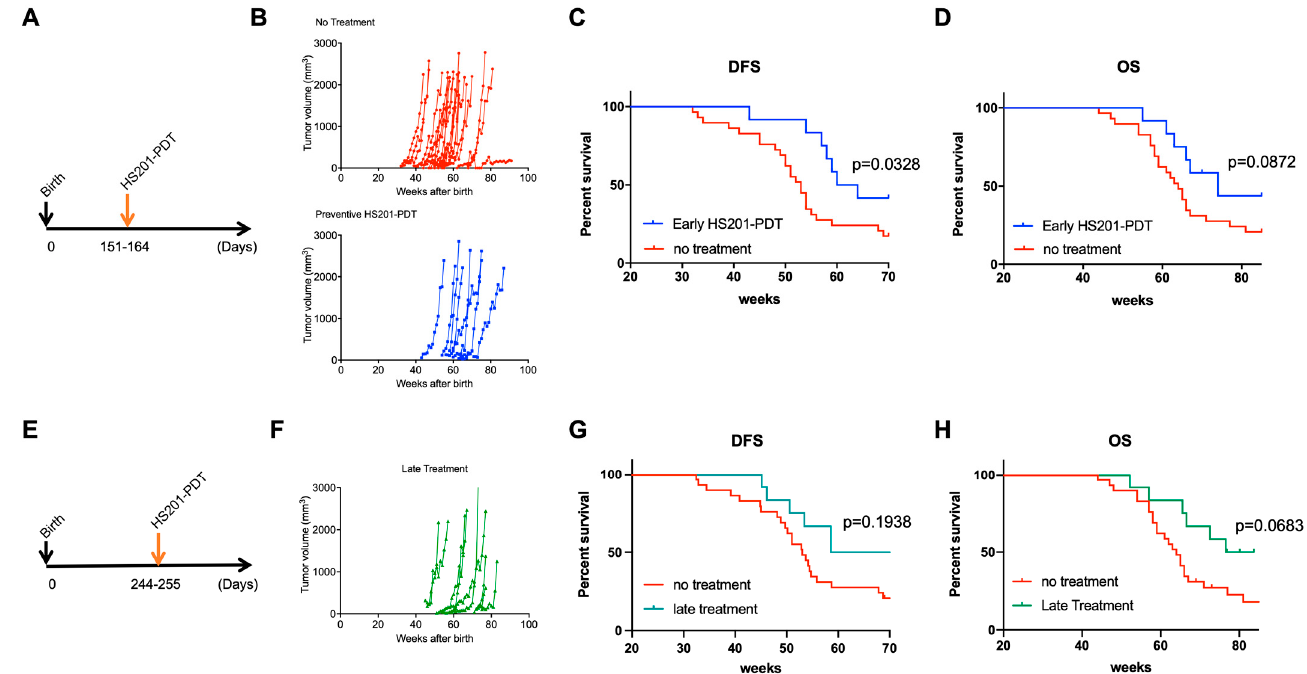
Figure 4. Survival benefits of preventive HS201-PDT for MMTV-neu mice. ( A ) Preventive HS201-PDT was conducted for 5-month-old (151–164 days after birth) female MMTV-neu mice. Six hours after intravenous administration of HS201 (25 nmol/mouse), a 30 J/cm 2 laser dose was used to irradiate each of 7 irradiation areas. Tumor growth was monitored every week until humane endpoints or till the age of 85 weeks. Control mice in no-treatment group were monitored for tumor emergence and tumor growth without any treatment. N = 29 for no-treatment group and n = 12 for early HS201-PDT group. ( B ) Tumor growth for individual mice is plotted. ( C ) Kaplan–Meier curves of disease-free survival are shown for HS201-PDT early treatment group and no-treatment control group. ( D ) Kaplan–Meier curves of overall survival are shown for HS201-PDT early treatment group and no-treatment control group. ( E ) Preventive HS201-PDT was conducted for 8-month-old (244–255 days after birth) female MMTV-neu mice. HS201-PDT was performed, and tumor growth was monitored until humane endpoints or till the age of 85 weeks, as described in ( A ). N = 29 for no-treatment group and n = 12 for late HS201-PDT group. ( F ) Tumor growth for individual mice is plotted. ( G ) Kaplan–Meier curves of disease-free survival are shown for HS201-PDT late treatment group and no-treatment control group. The same survival curve for no-treatment control group is shown for comparison purposes. ( H ) Kaplan–Meier curves of overall survival are shown for HS201-PDT late treatment group and no-treatment control group.